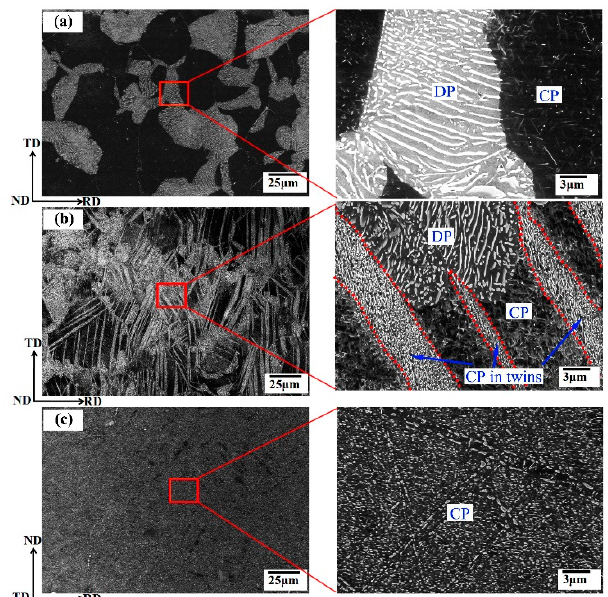
Figure 1. Scanning electron microscope (SEM) micrographs of rolled AZ80 alloys ( a ) direct aged, ( b ) compressed 3.5% along TD and then aged and ( c ) compressed 10% along TD and then aged. Red dotted lines in ( b ) outline twin boundaries. The micrographs at the right-side were taken at higher magnification from the corresponding marked areas [28].